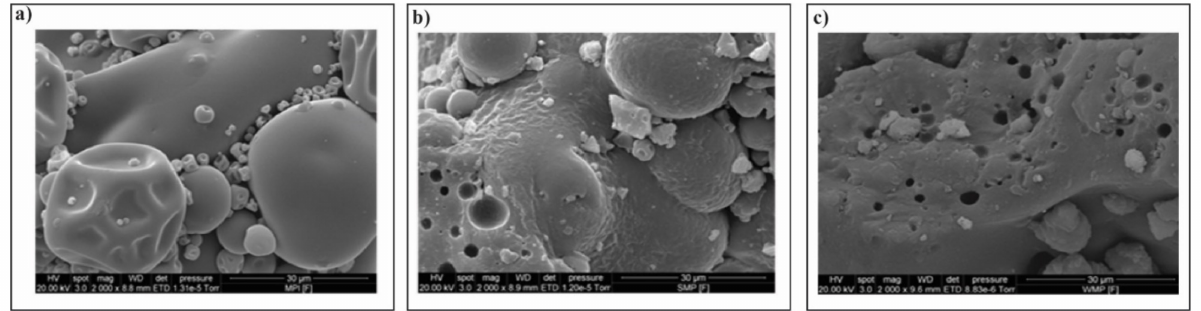
Figure 2. Scanning Electron Microscopy (SEM) images of fluidized bed-dried Lactobacillus paracasei powders in MPI ( a ), SMP ( b ) or WMP ( c ).